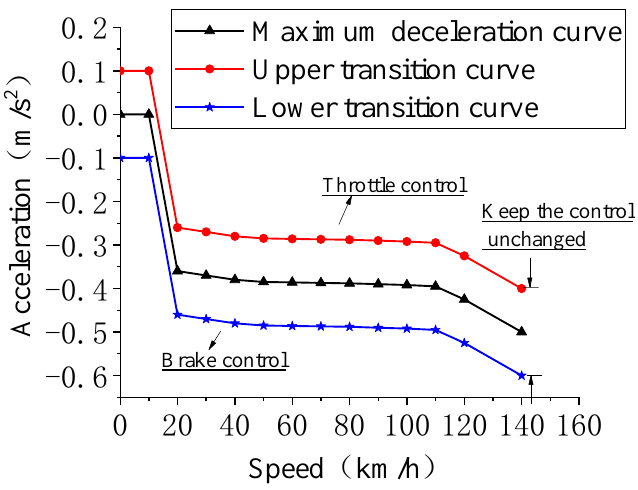
Figure 5. Acceleration/braking switching curve.